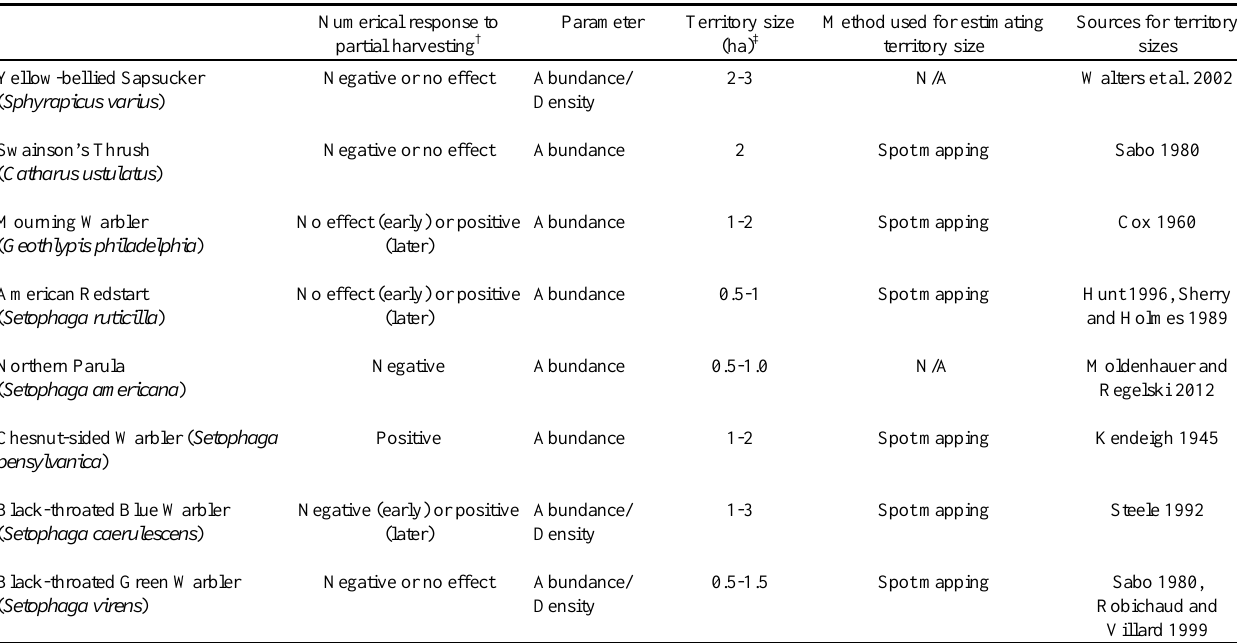
Table 1 . Numerical responses to partial harvesting in northern hardwood forests and territory sizes of focal bird species according to the